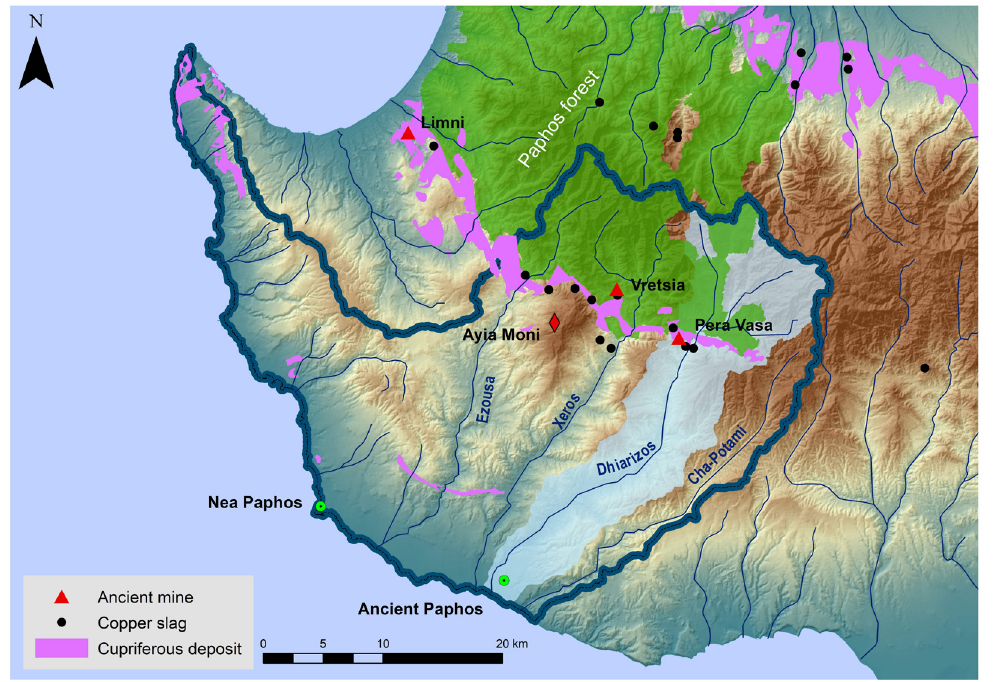
Figure 10. Cupriferous deposits and slag heaps in the Paphos hydrological basin (catchment). Digital geological data from Cyprus Geological Survey. Drafted by A. Agapiou